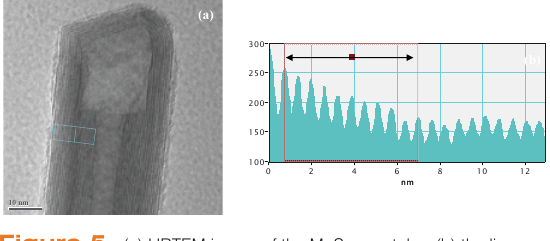
Figure 5. (a) HRTEM image of the MoS nanotube, (b) the line pro- 2 file of the boxed area in the figure (a) gives an interlayer spacing of 6.2 Å (adapted from Ref. 42).